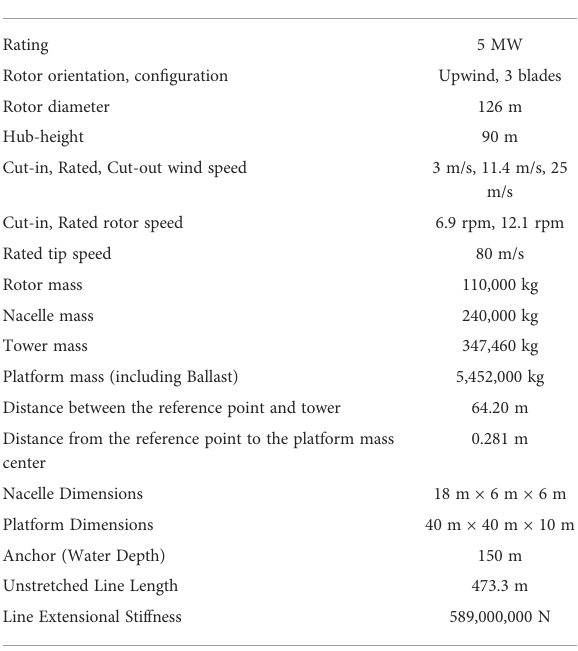
TABLE 1 Basic parameters of the barge FOWT.